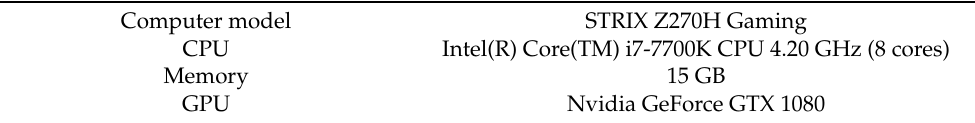
Table 2. Computer configuration applied in our experiments.